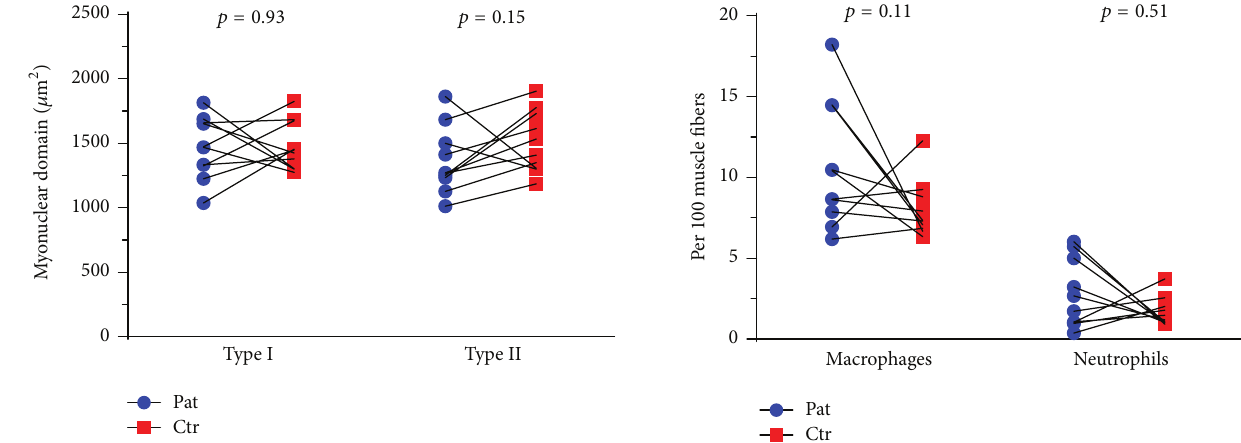
Figure 4: Number of CD68 positive macrophages and CD66b positive neutrophils in ECM in m. vastus lateralis . Lines drawn signify the pairwise match of patient-control; some lines appear duplicated as they represent pairs with similar